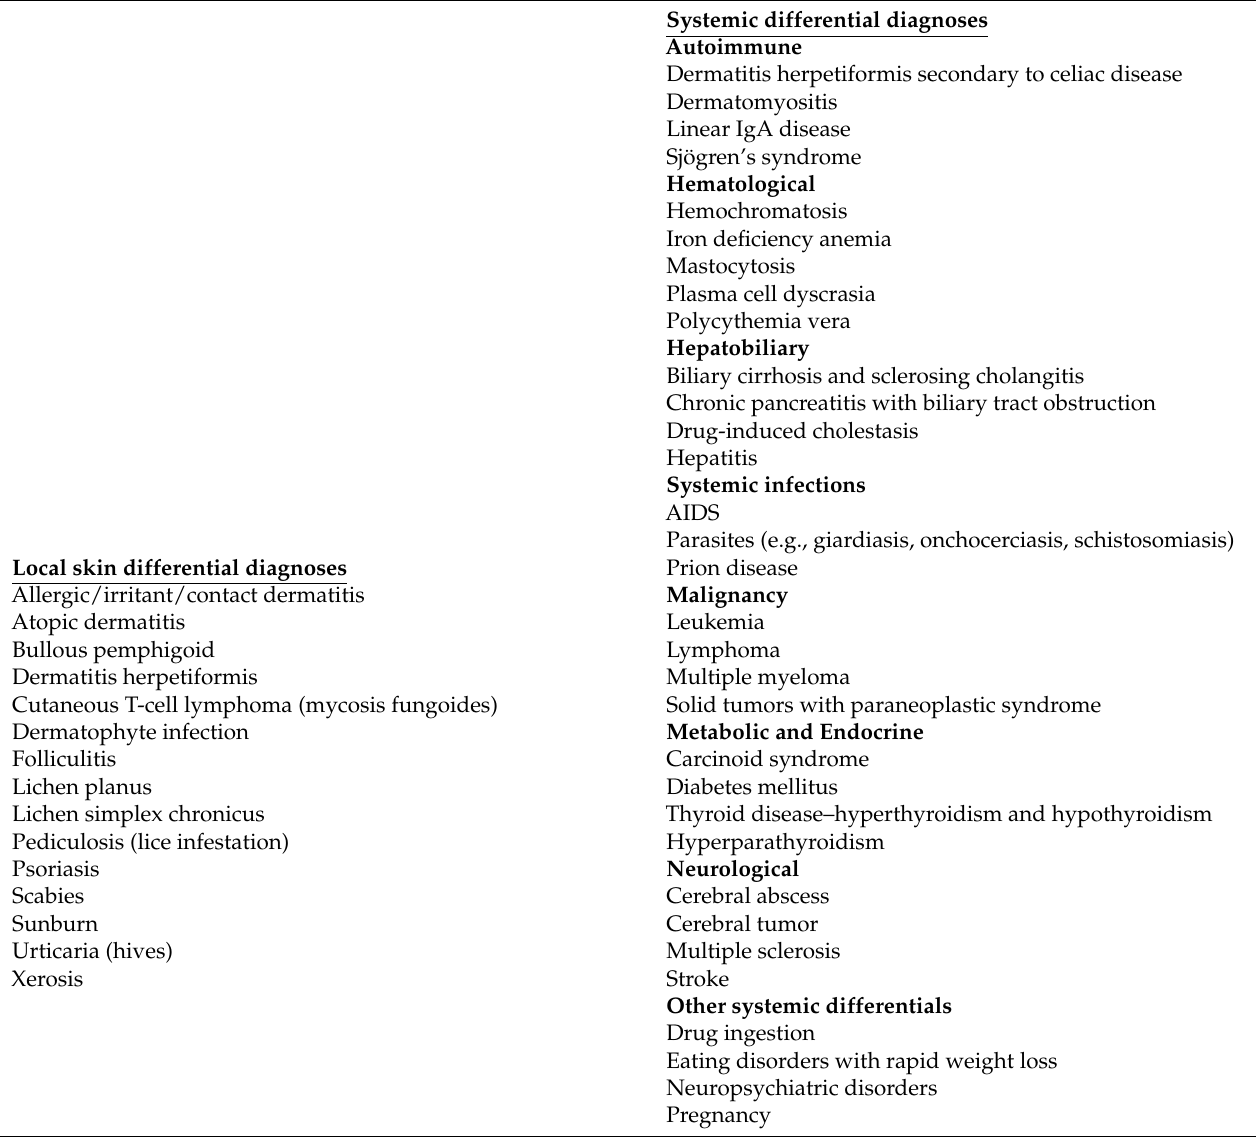
Table 1. Differential diagnoses of